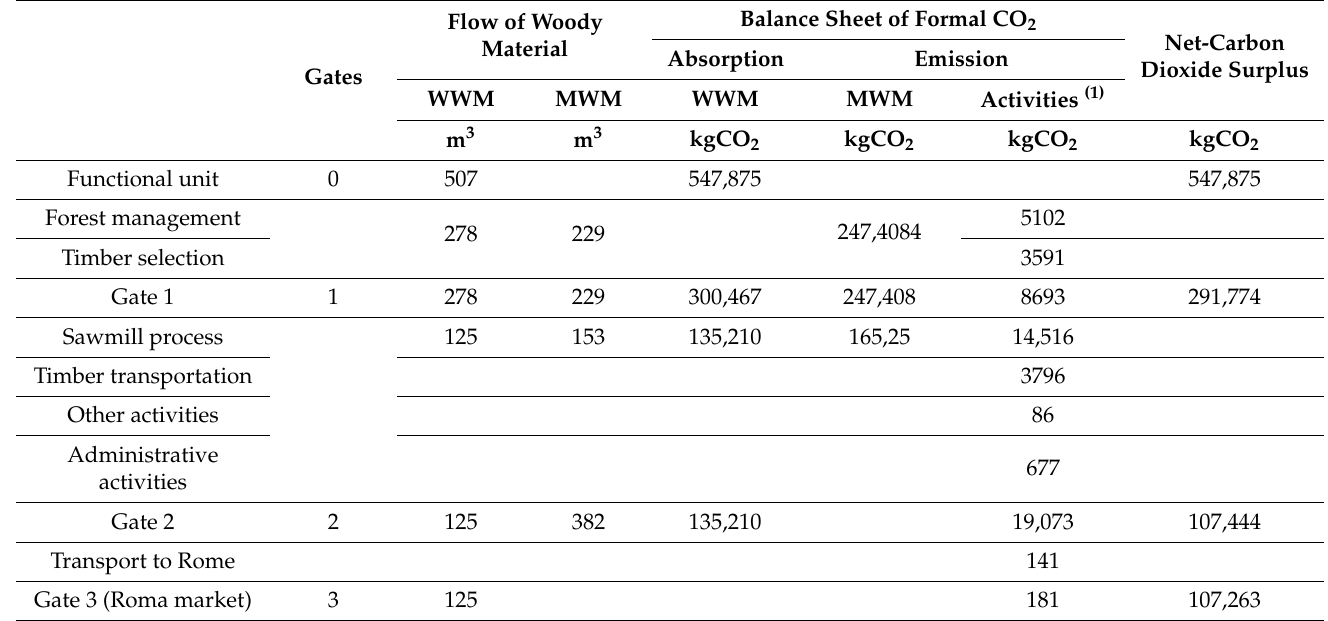
Figure 5. CO 2 emissions by types of sources. Table 13. Flow of chestnut wood material and formal balance sheet of CO 2 . Legend: (1)